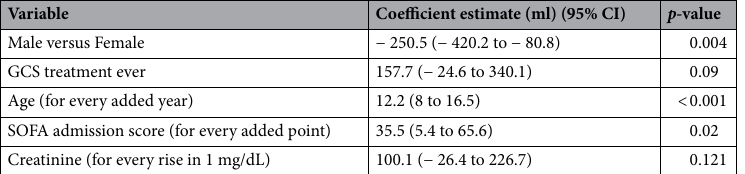
Table 5. Model 4 of the estimated effect of ever being treated with glucocorticoids (GCS) on daily fluid balance (ml) in patients with sepsis in the intensive care unit. This model included only days without GCS treatment. SOFA sequential organ failure